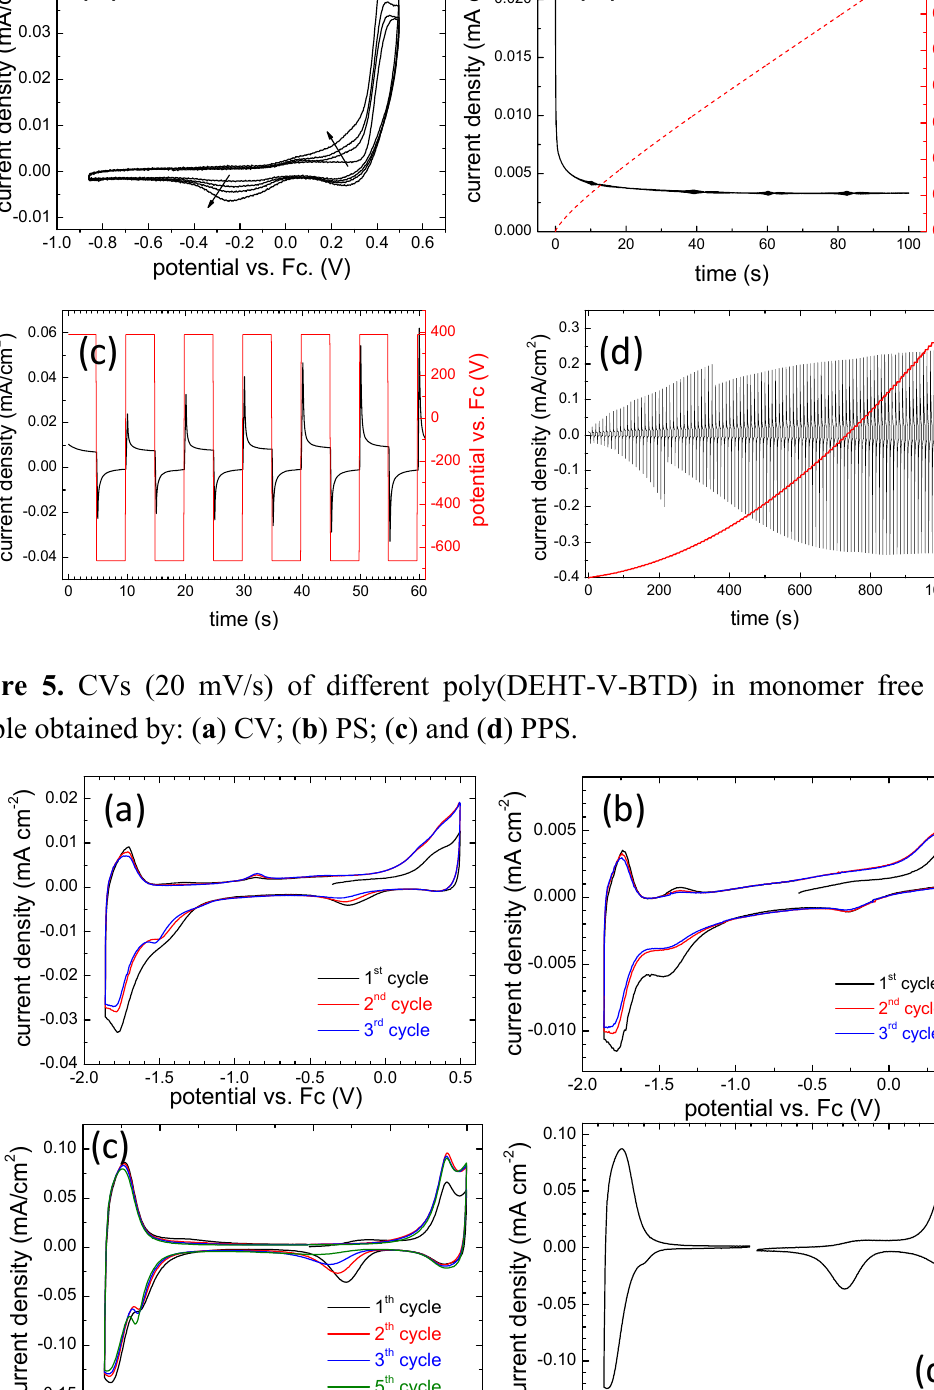
-1.0 -0.8 -0.6 -0.4 -0.2 0.0 0.2